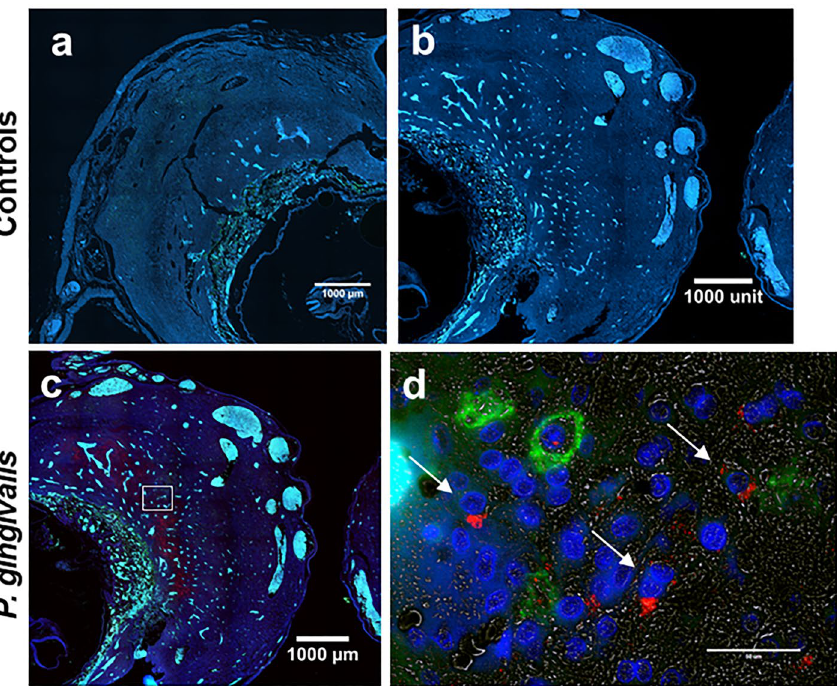
Figure 1. Representative images of P. gingivalis in GD11 specimens. ( a ) Stained section from an uninfected control. ( b ) Corresponding isotype control for P. gingivalis positive specimen. ( c ) Low magnified image of a P. gingivalis positive specimen. Boxed region indicates the region that is pictured in ( d ). Transillumination (grey) was used to define the tissue architecture in decidual stroma in ( d ). Scale bar = 50 µm. ( a–c ) Are tiled composites of individual pictures taken at × 10 magnification with an EVOS Auto FL imaging system. Scale bar = 1000 µm. Tissue sections were dual stained with an antibody to NK cell marker, a-natural killer cell activation structures (green) and P. gingivalis (red, white arrows). DAPI (blue) was used as a nuclear